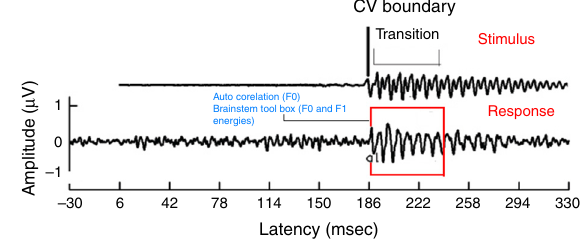
Figure 3 Transition response of FFR obtained from /si/ stim- ulus in aided